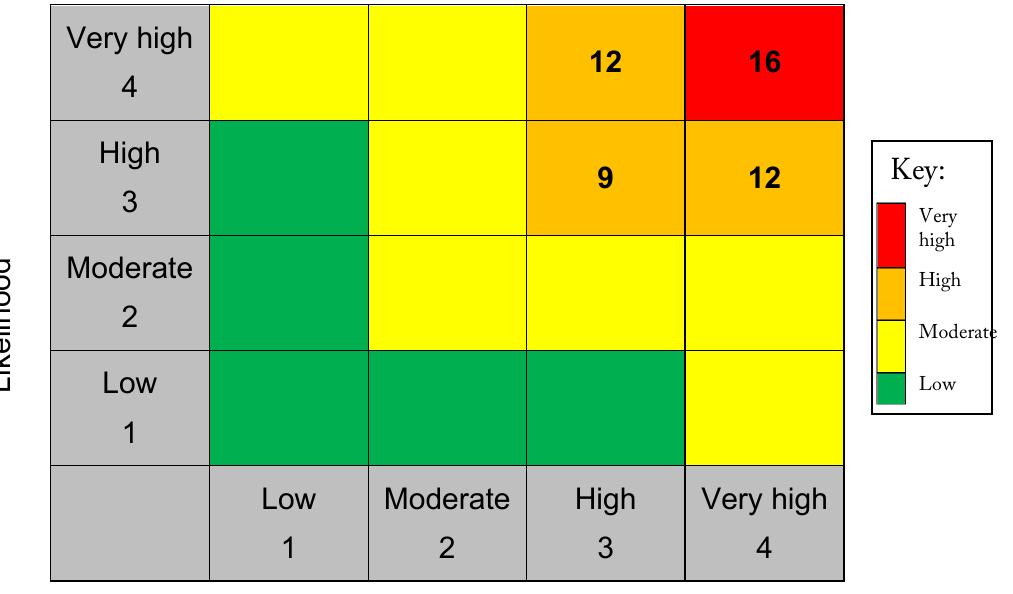
Table 4: Risk heat map of the assessment of the risk of a smothered caring human spirit for HEIs